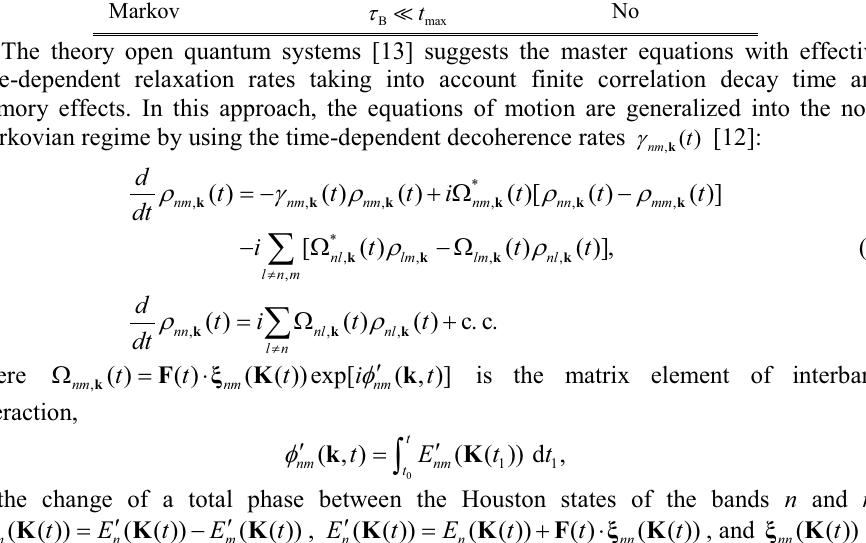
(cid:10) (cid:10) (cid:2) Yes B R Partial g